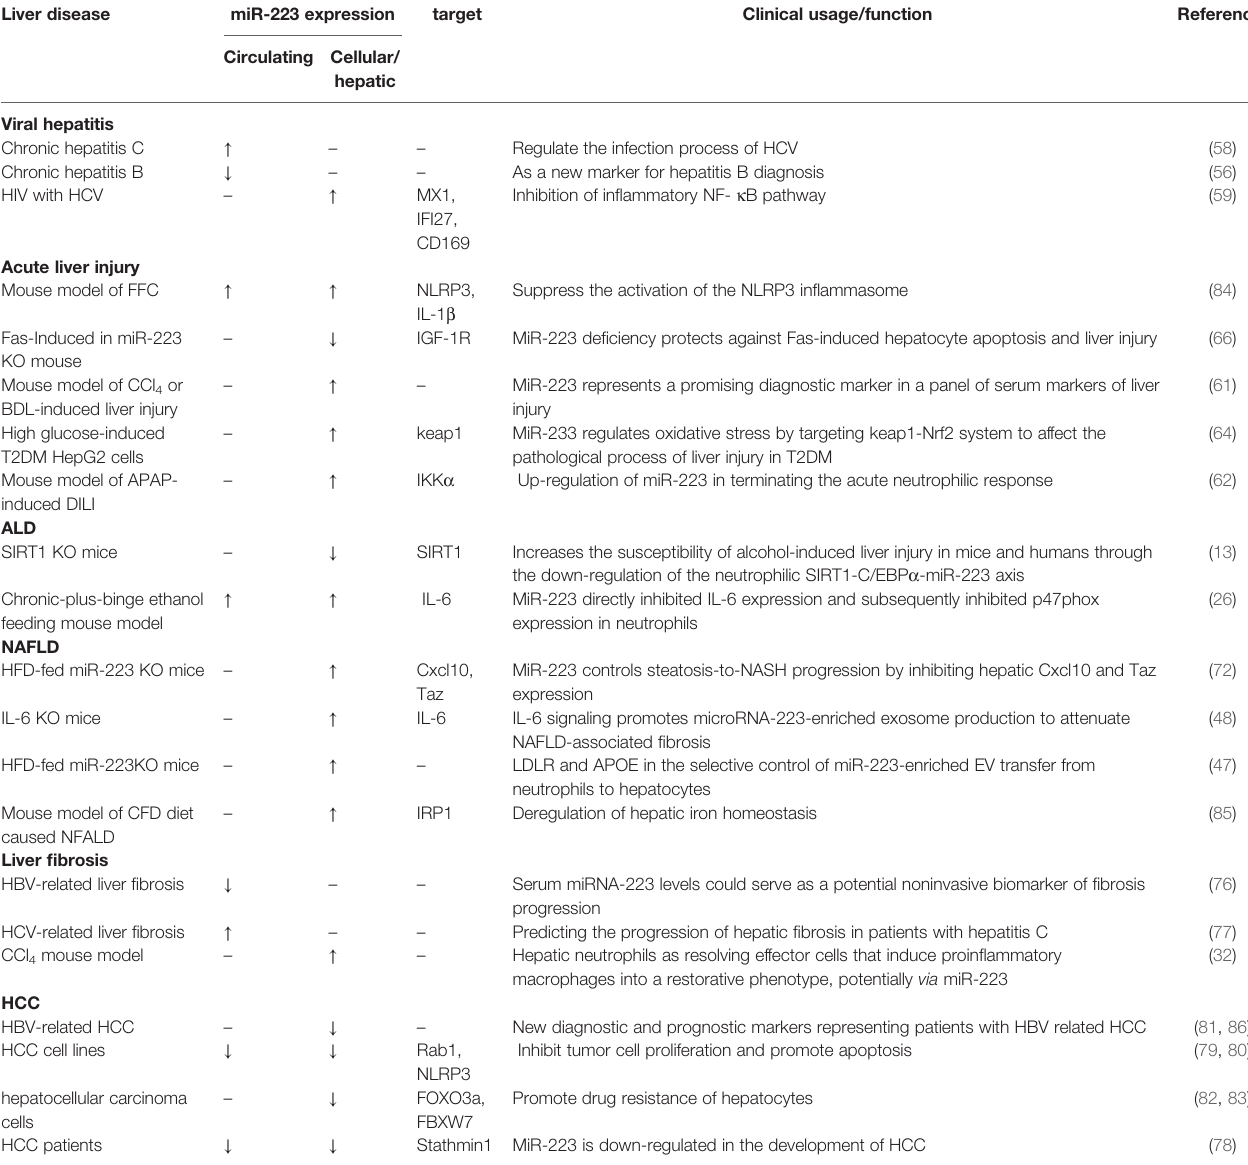
TABLE 1 | MiR-223 expression, target, and function in liver diseases. Liver disease miR-223 expression target Clinical usage/function